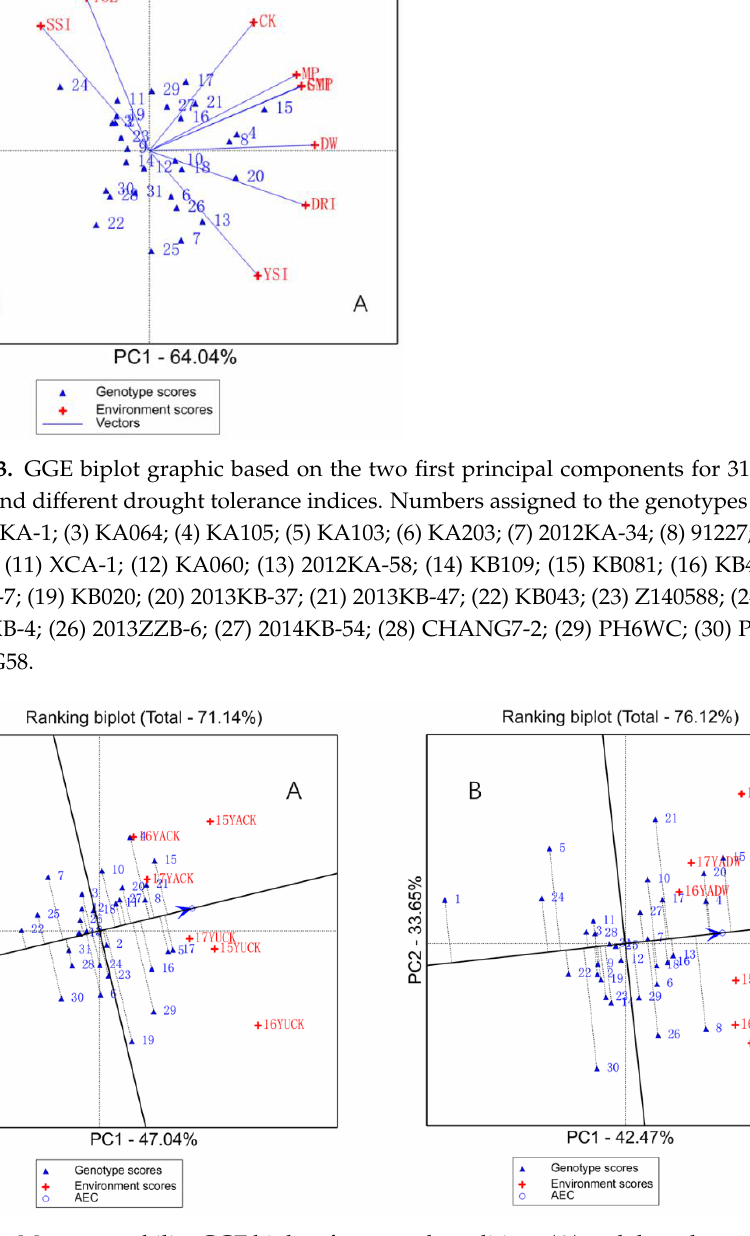
Figure 5. Mean vs. stability GGE biplots for Yangling ( A ) and Yulin ( B ). 4. Discussion Here, we used the yield to calculate drought tolerance indicators and combine PCA and GGE biplot analysis to classify the inbred lines of maize. Khalatbari [20] showed that GMP and STI are suitable indices for evaluating drought tolerance in maize inbred lines, as these consider yield stability and also high yield. The results of Zhao et al. [21] showed that DRI can be used as an indicator to evaluate the drought resistance of wheat ( Triticum aestivum L.) varieties. Within the drought tolerance research literature, various index sys- tems have been established to evaluate the drought tolerance of plant materials, but they all indicate systematic consistency. Therefore, the indicators of drought tolerance in maize inbred lines can also be applied to newly selected inbred lines. A comprehensive evalua- tion of drought tolerance is more reasonable. Comprehensive consideration of the three indices (MP, GMP, and STI) should be preferred for screening drought-tolerant maize va- rieties with the same as that of Fernandez [13] and Shaban et al. [22].